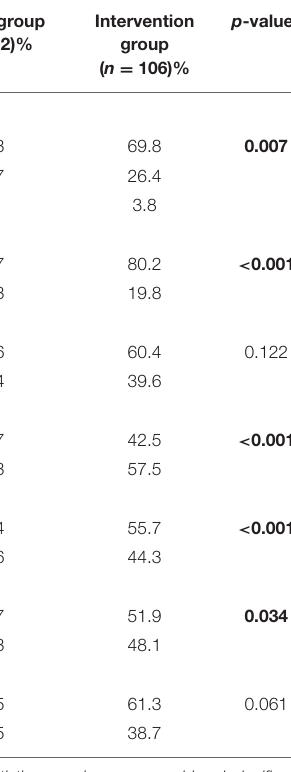
TABLE 2 | Descriptive statistics of the sample ( n =